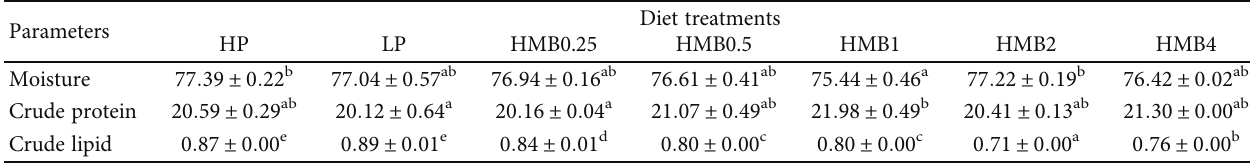
Table 5: Muscle proximate composition (% wet matter) of kuruma shrimp fed with the experimental diets.